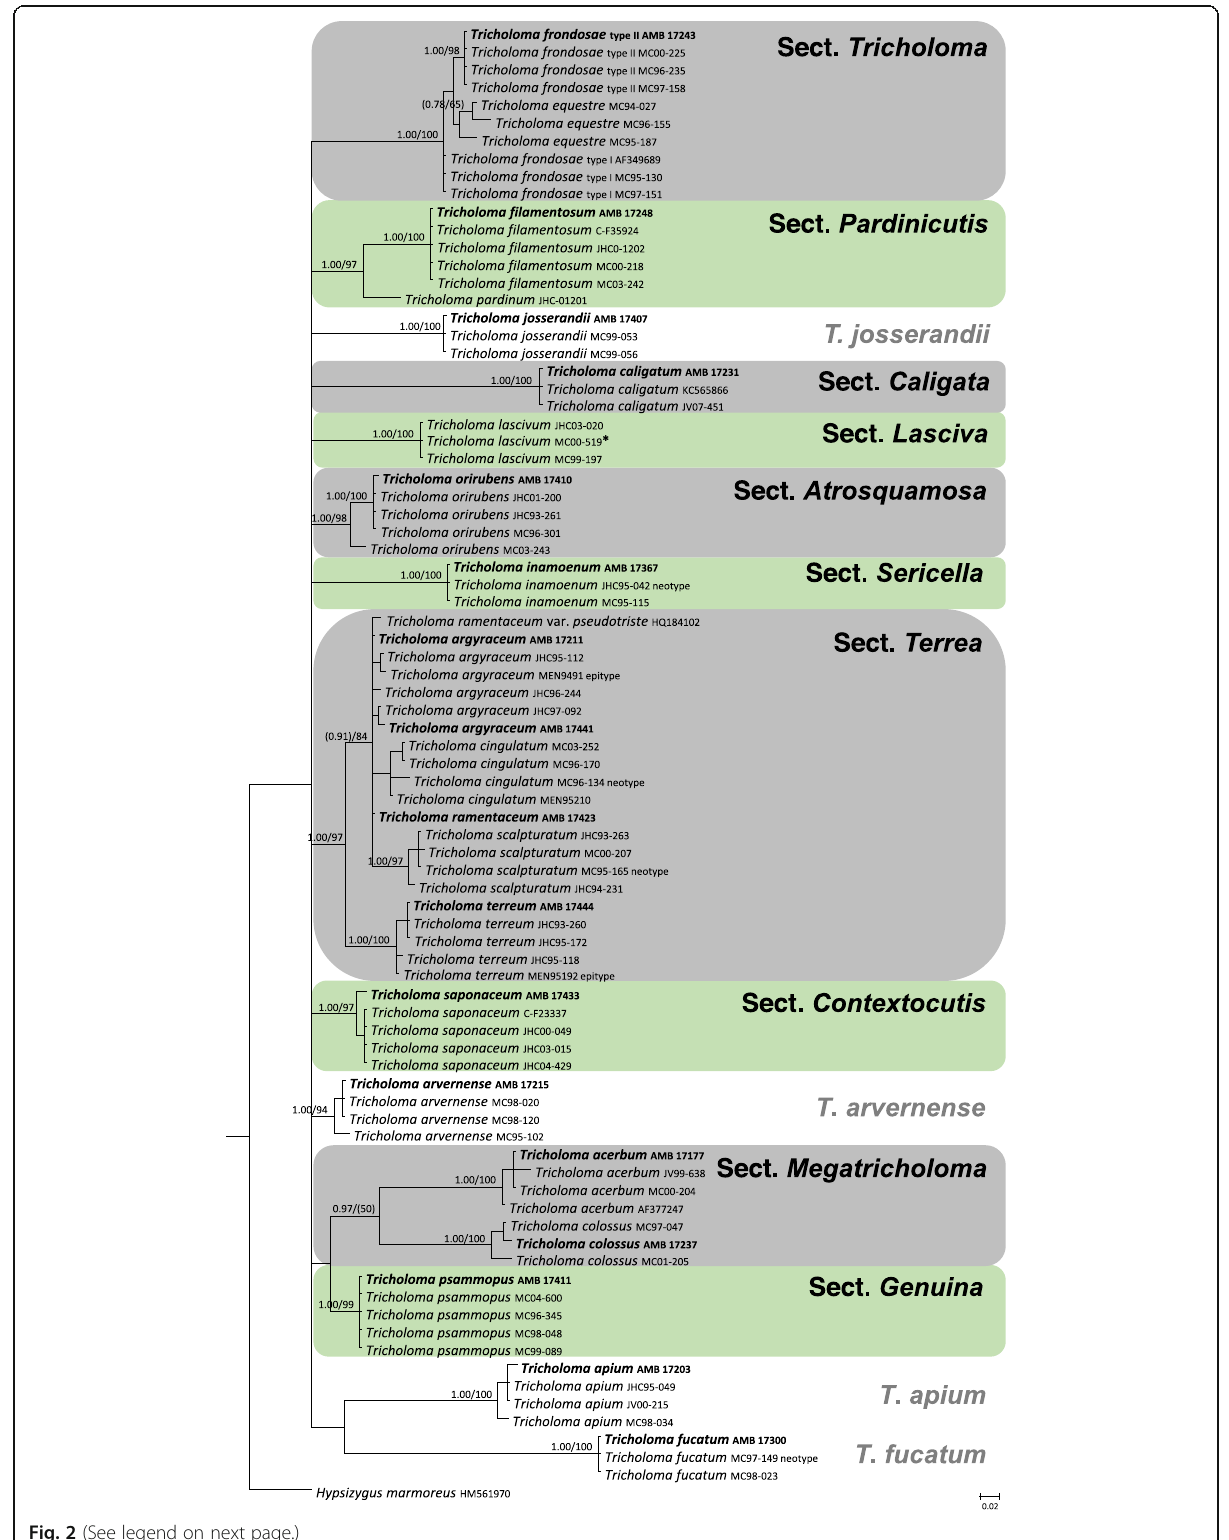
Fig. 2 (See legend on next